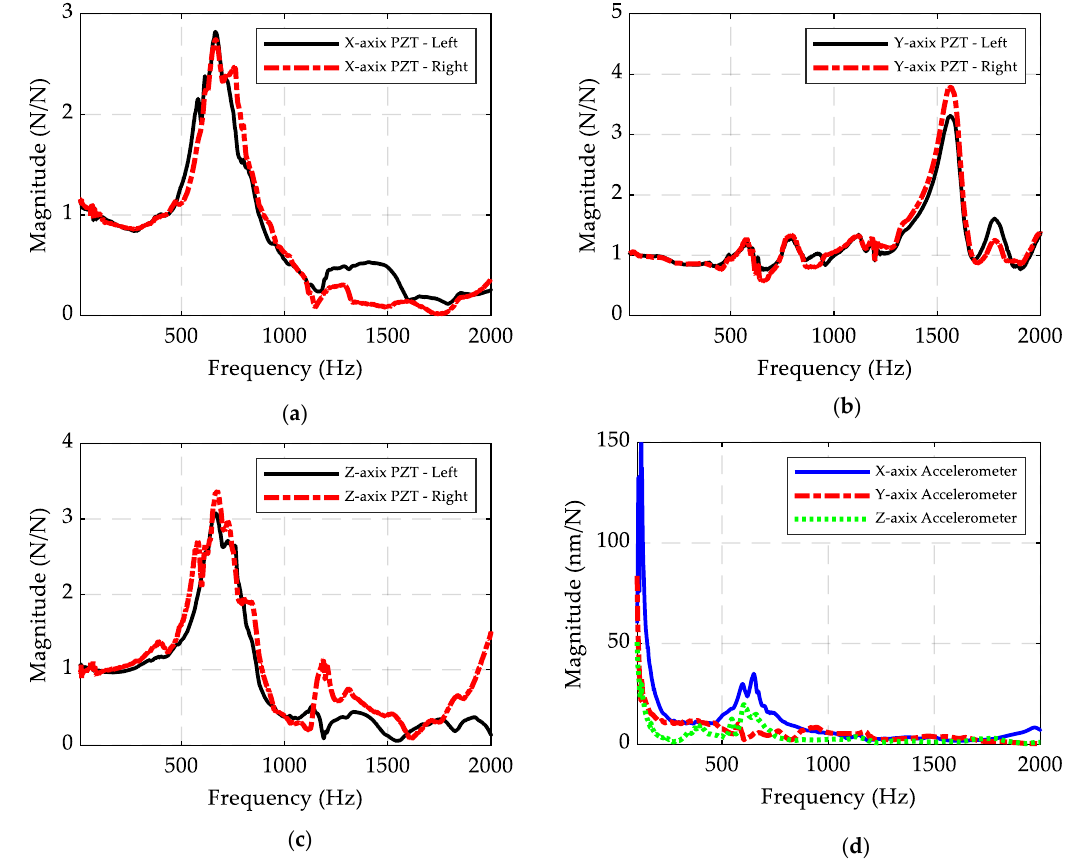
Figure 15. Experimental hammer test FRF results measured by ( a ) piezoelectric sensors in the X -axis from the X -axis force ( 𝐻 𝑥𝑥 ), ( b ) piezoelectric sensors in the Y -axis from the Y -axis force ( 𝐻 𝑦𝑦 ), and ( c ) piezoelectric sensors in the Z -axis from the Z -axis force ( 𝐻 𝑧𝑧 ); ( d ) and measured by an accelerometer from X-, Y-, and Z-axis forces ( 𝐻 𝑥𝑥 , 𝐻 𝑦𝑦 , 𝐻 𝑧𝑧 ).